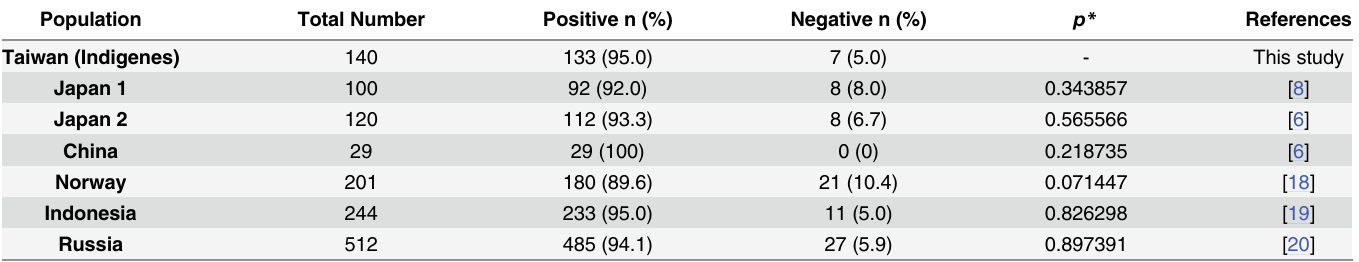
Table 1. Comparison of the TTV ’ s prevalence detected by UTR region between eastern Taiwanese indigenous population and general population from other geographic regions.